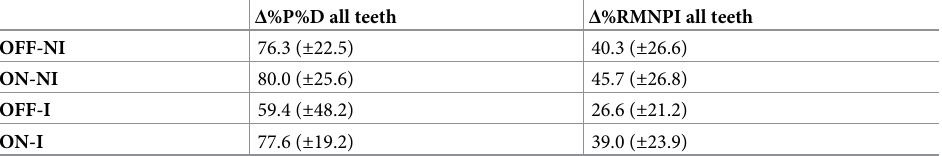
Fig 5. Boxplots of disclosed plaque of the total tooth surface (P%D) per tooth at baseline and post-brushing. All differences in P%D values between baseline and post-brushing were significant. Baseline: after 4 days refraining from oral hygiene; Post-brushing: after a single brushing exercise. OFF-NI: habitual brushing in OFF mode; ON-NI: habitual brushing in ON mode; OFF-I: post instruction brushing with the Modified Bass Technique in OFF mode; ON-I: post instruction brushing according to the manufacturer in ON mode; PM1 = first premolar; PM2 = second premolar; M1 = first molar. https://doi.org/10.1371/journal.pone.0261496.g005 The regression analysis revealed no significant difference for differences between baseline and post-brushing values between the OFF and ON modes with habitual brushing (ON-NI vs. OFF-NI; p = 0.224). Even after instruction, brushing with the sonication switched on did not result in better plaque reduction than habitual brushing in the OFF mode (OFF-NI vs. ON-I; Table 2. Descriptive presentation of the percentage reduction between baseline and post-brushing for planimetric values ( Δ %P%D), and for RMNPI values ( Δ %RMNPI) averaged over the three teeth given as mean ( ±